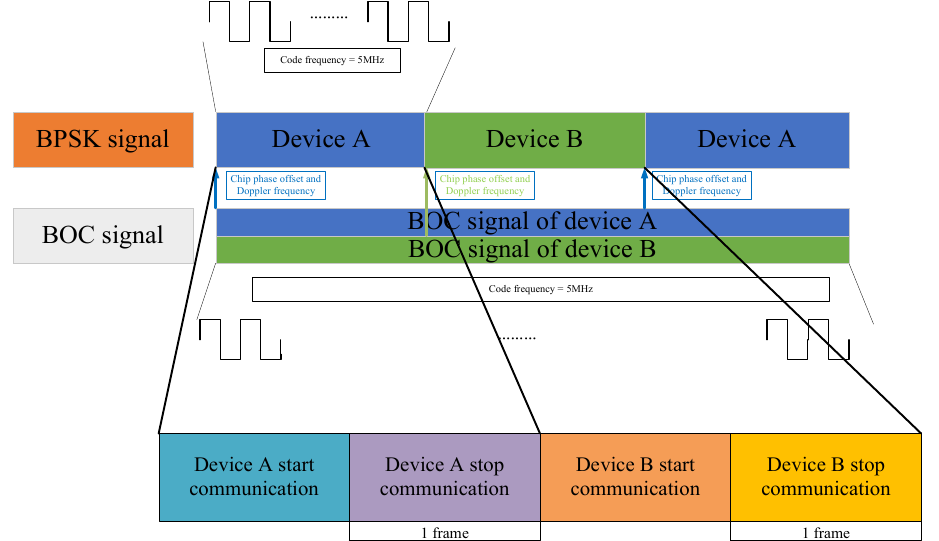
Figure 7. The time sequence of device C in the fast-switching process.